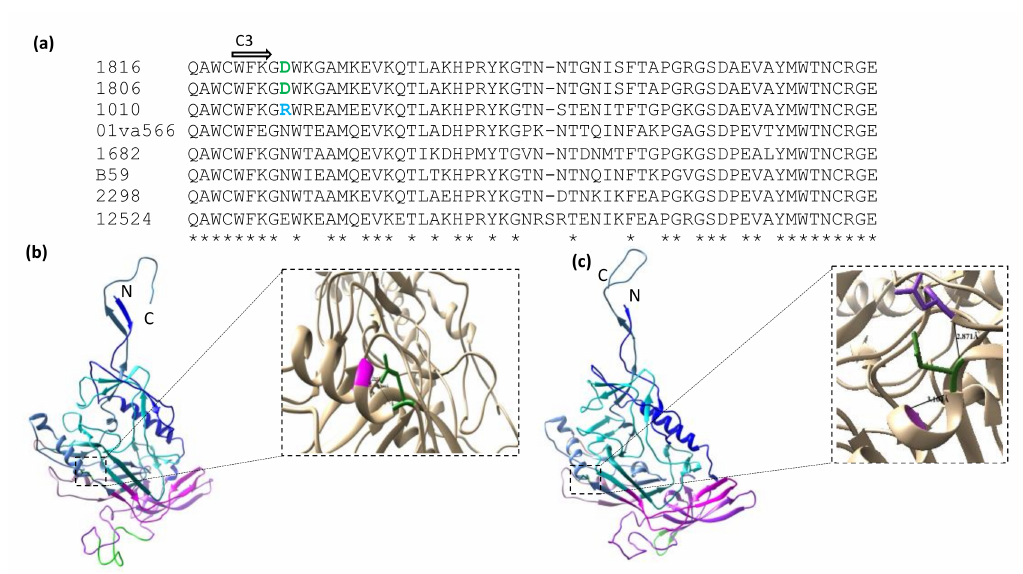
Figure 4. Effect of amino acid polymorphisms in the A2 helix of the gp125 C3 region. ( a ) Amino acid alignment of N-terminal region of C3 domain of HIV-2 isolates. ( b ) Homology model of 1816 Env. ( c ) Homology model of 1682 Env. The 3-dimensional gp120 monomers were obtained from Swissmodel repository. The different domains represented by different colours: C1 is blue; V1/V2 purple, whereas the insertion in this region is green; C2 is cyan blue; V3 is magenta; C3 is cornflower blue; V4 is plum; C4 is dark cyan; V5 is salmon; C5 is steel blue. Critical amino acids in the 5th position of the C3 region is represented with forest green and formed hydrogen bonds are represented with black lines for both of the isolates. “-” indicates lack of insertion in sequences except, isolate 12524. Consensus across tested HIV-2 isolates’ sequences aligned is indicated below each amino acid residue by symbol “*”. The model structures of gp125 were obtained from the Swissmodel